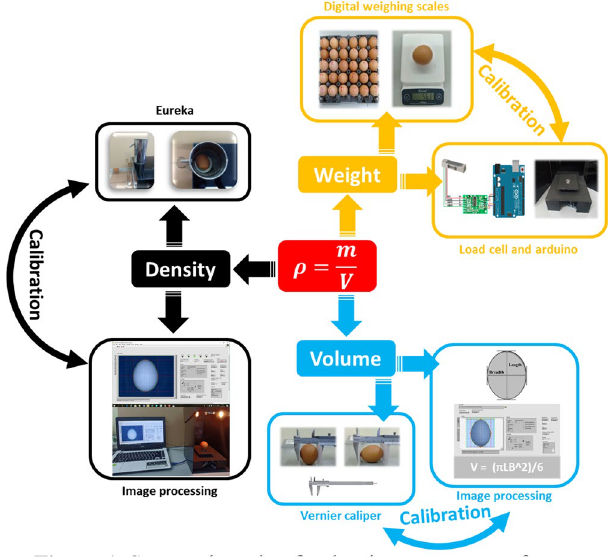
Figure 1. System detection for density assessment of eggs.